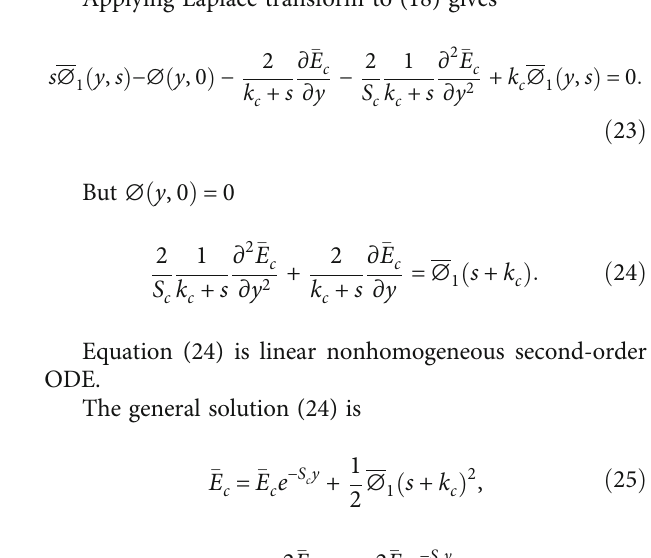
Figure 7: Distinct values of time t for concentration fi eld when Kc = 1 : 5 , Ec = 0 : 1 , and Sc = 2 : 01